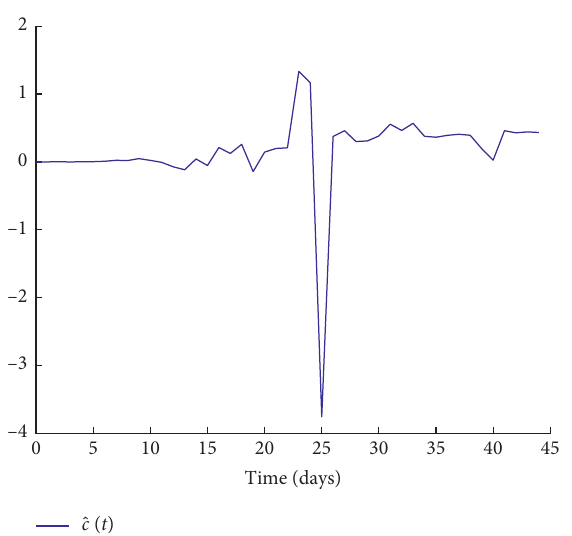
Figure 15: Estimation of the Malthusian parameter from reported data (Italy) and lsqcurvefit Matlab function.